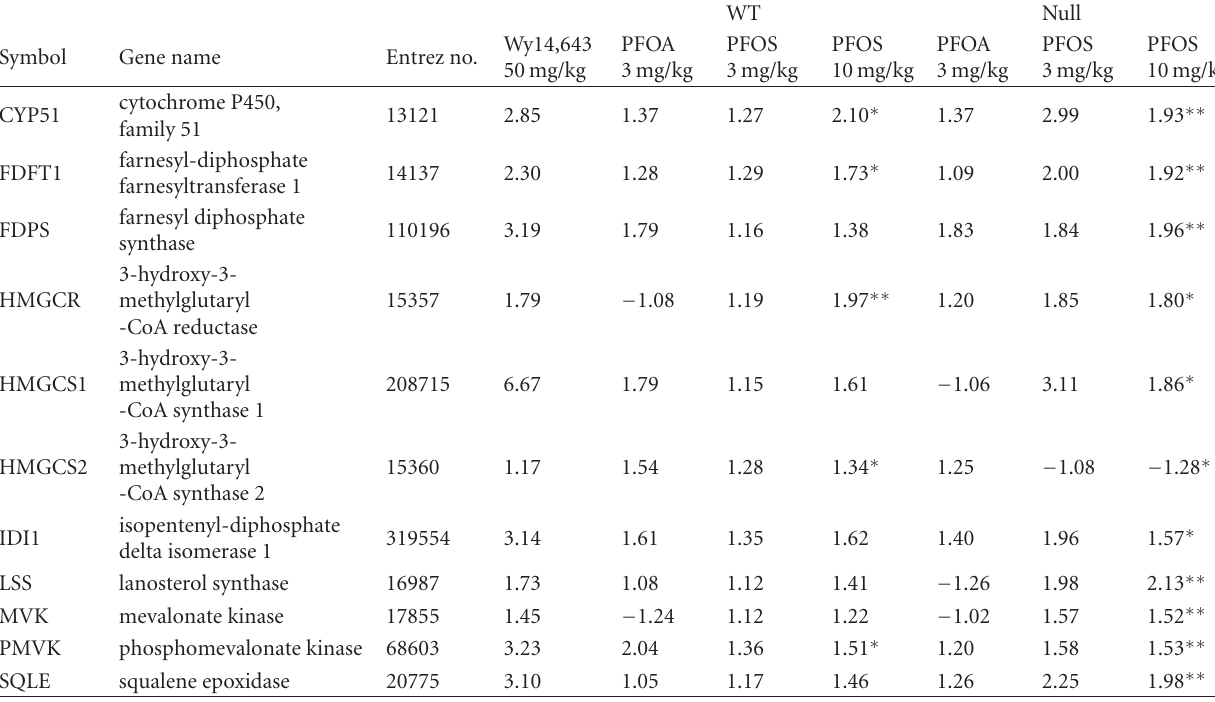
Table 8: Average fold change for genes related to cholesterol biosynthesis in wild-type and PPAR α -null male mice following a seven-day exposure to Wy-14,643 1 , PFOA 1 , or